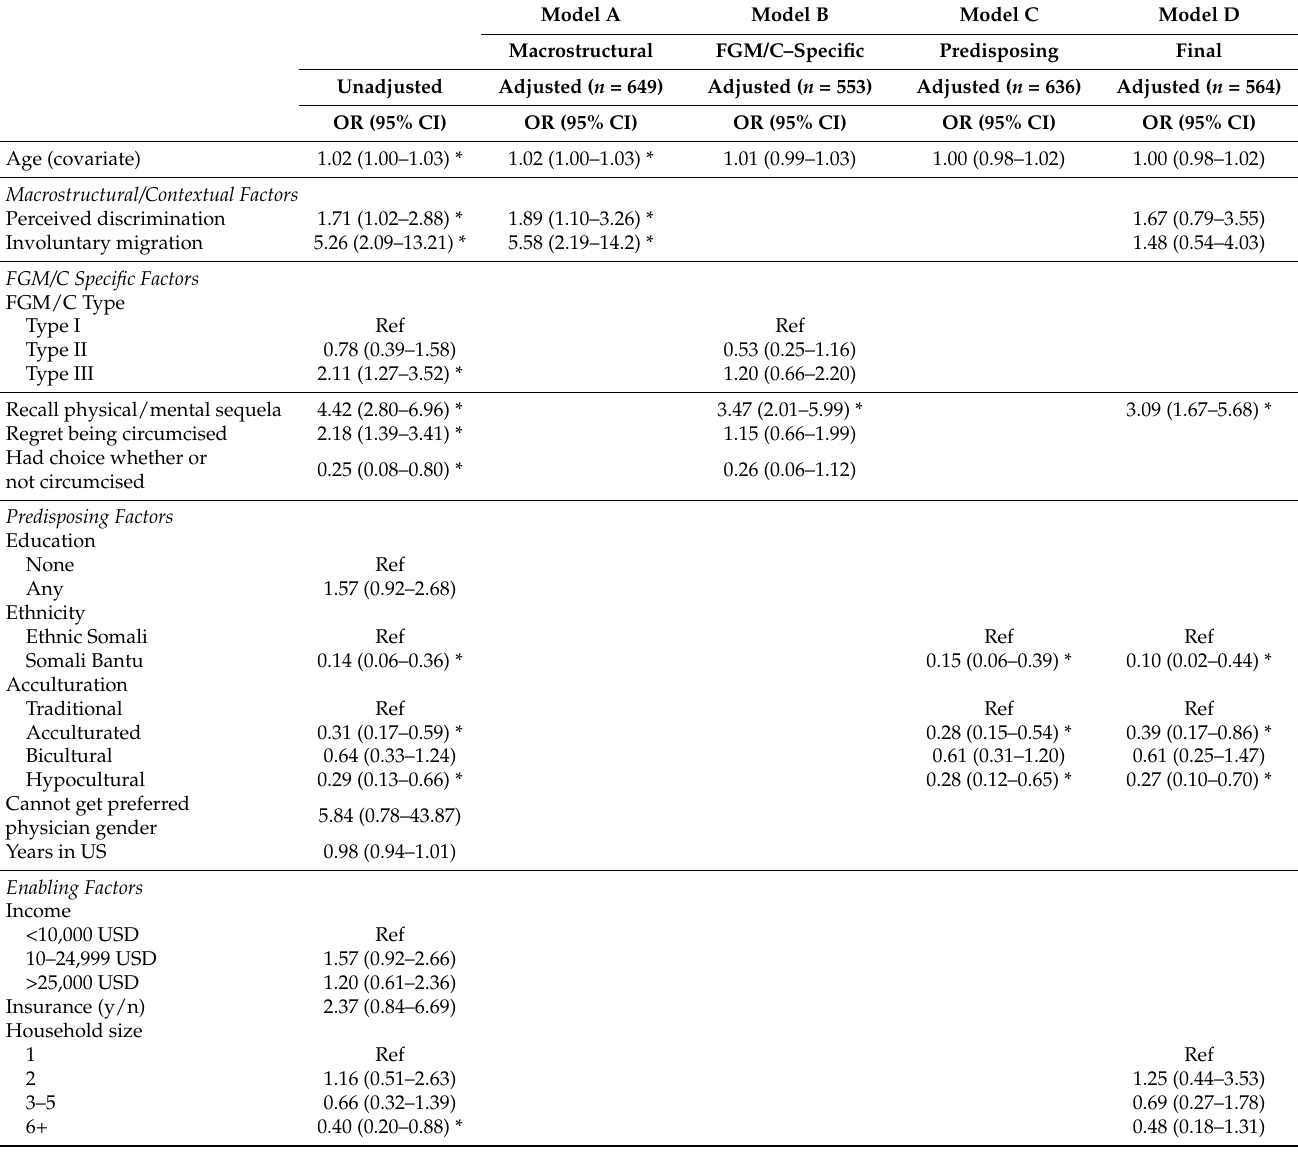
Table 3. Unadjusted and Adjusted Odds Ratios of FGM/C Factors affecting FGM/C-related Health Service